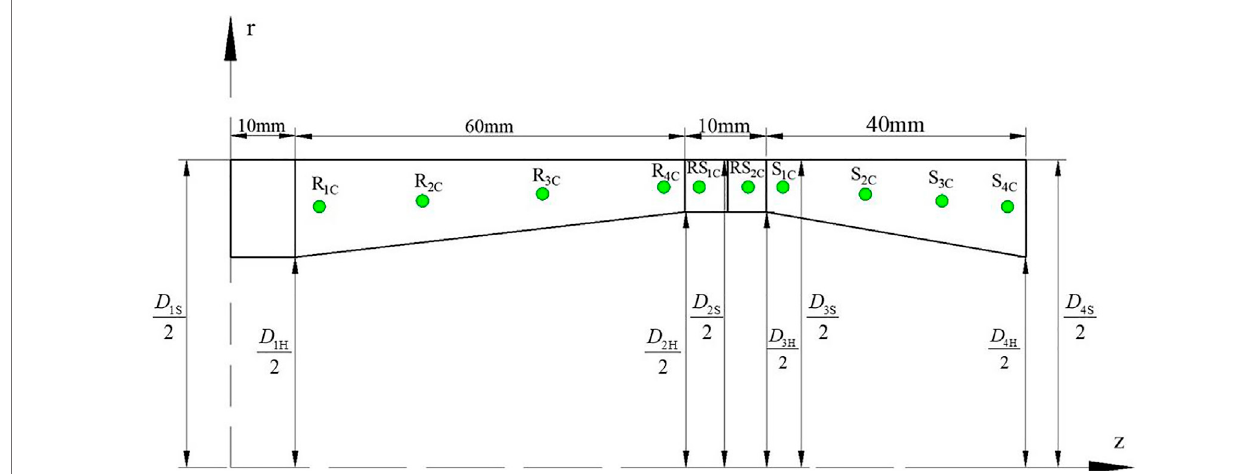
FIGURE 15 | Locations of monitoring points.